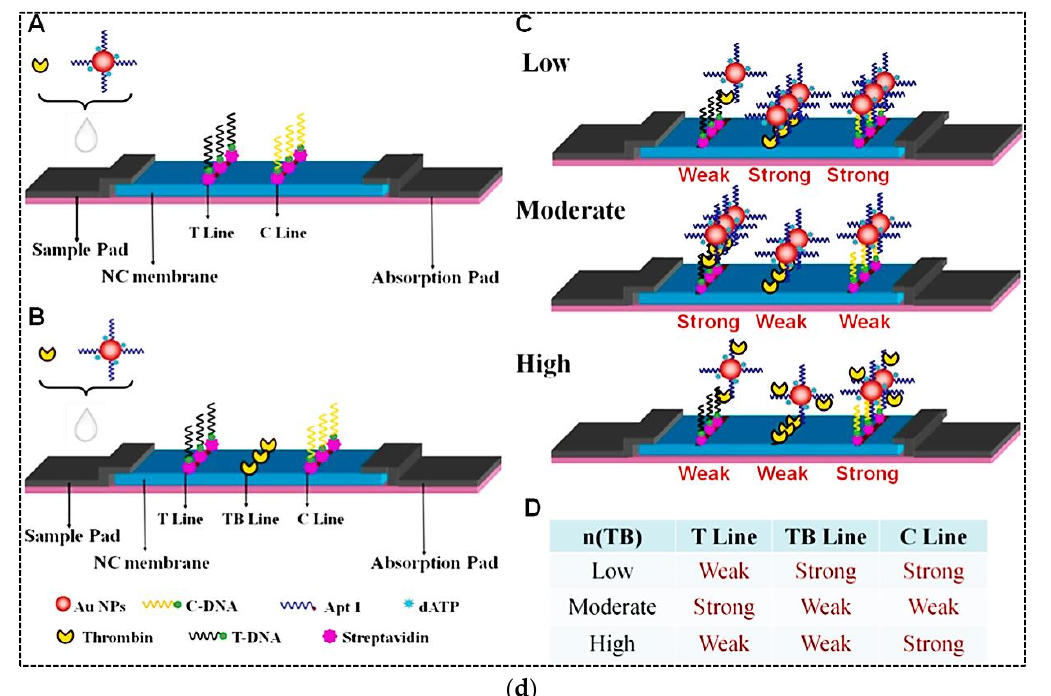
Figure 3. ( a ) A schematic representation of the duplex dissociation mechanism for the detection of dopamine. ( b ) Adsorption–desorption colorimetric LFA for HER2. ( c ) An aptamer-based competi- tive LFA using gold nanozyme as a label for the detection of CA125. ( d ) An aptamer-based hook- effect-recognizable three-line lateral flow biosensor for rapid detection of thrombin. Reprinted with permission from [37,38,40,41], respectively.